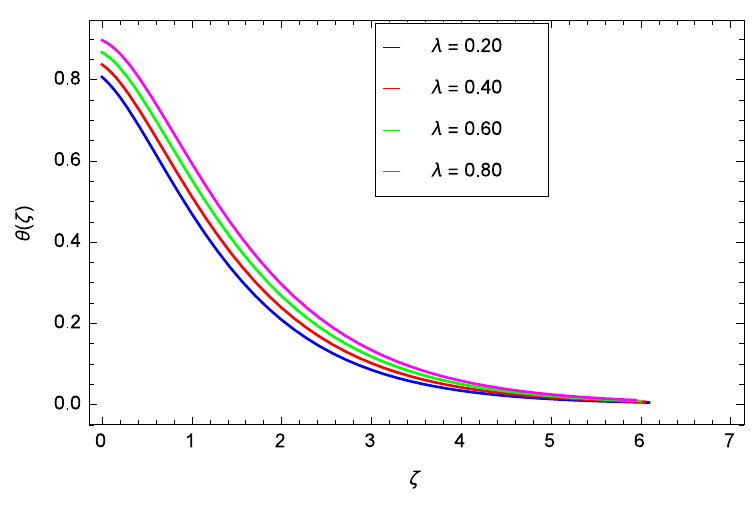
Figure 7. Influence of λ on θ ( ζ ) .